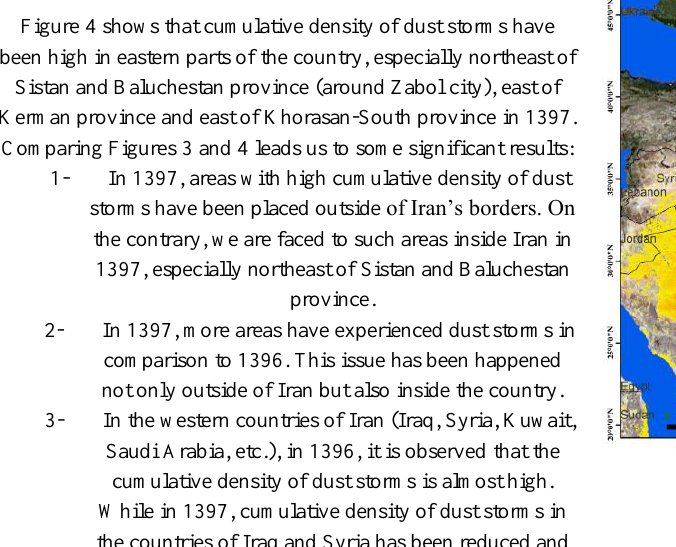
Figure 5. Frequency of occurrence map of dust storms in 1396 Hijri Shamsi